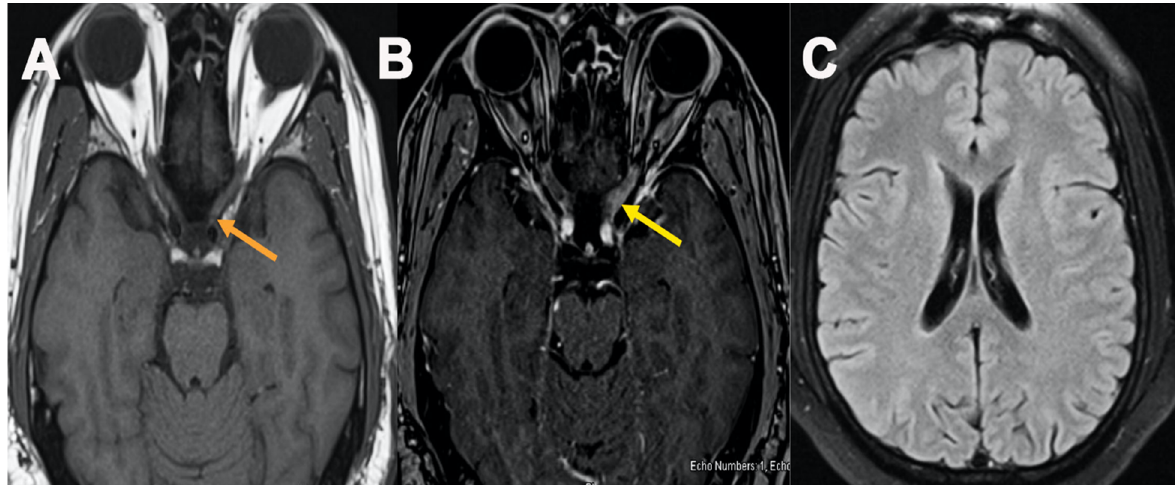
Figure 3. MRI orbit Figure 3, axial T1 plain 3 ( A ) and post contrast fat saturation axial images 3 ( B ) showed abnormal enhancement within the intracanalicular portion of left optic nerve 3 ( B ) (yellow arrow), MRI brain axial FLAIR cut at level of lateral ventricle showed no abnormal T2/FLAIR signal changes 3 ( C ).